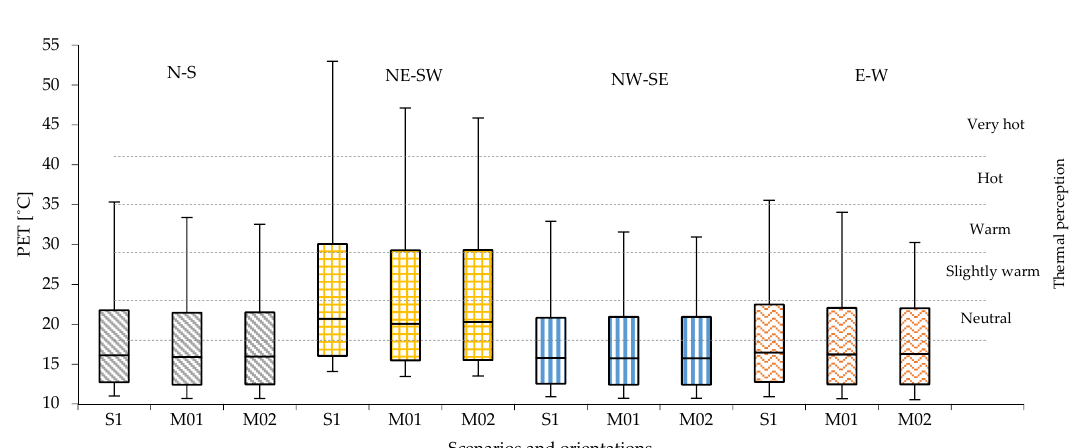
Figure 11. PET values measured in all 14 receptors in compact low-rise urban areas for scenario S1 with red brick stones and mitigation scenarios M01 (Ht / H = 0.25) and M02 (Ht / H = 0.25 and Wt / W = 0.30) in all orientations.